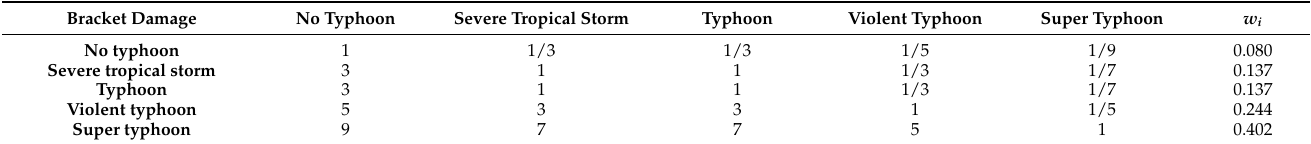
Table 10. Important degree judgment matrix for bracket damage under different typhoon intensity.